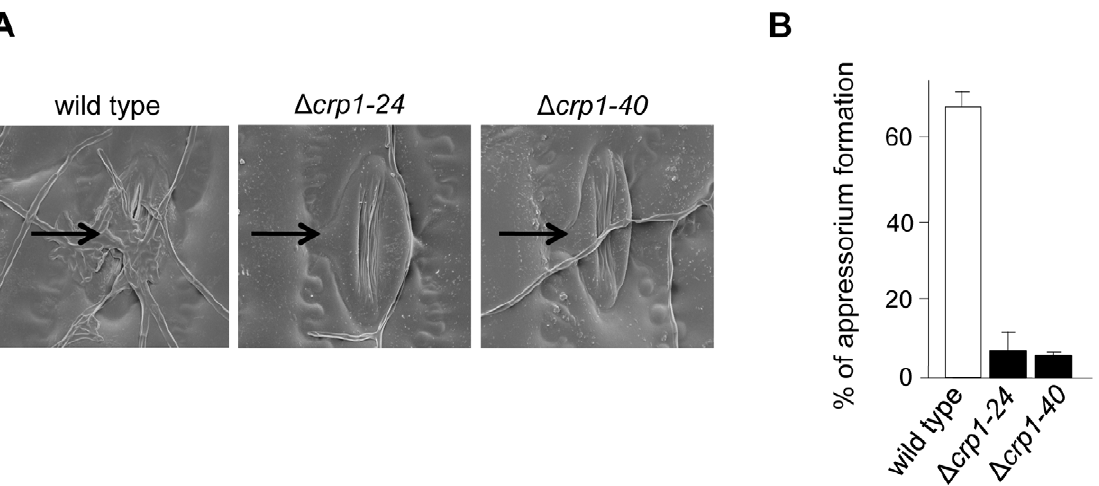
Figure 5. CRP1 regulates appressorium formation and stomatal tropism in C.zeae-maydis . A, leaves inoculated with wild type, the D crp1- 24 mutant, and D crp1-40 mutant were observed with electron microscopy. Stomata are indicated with black arrows. B, ratio of appressoria formed per stomate encountered for the wild type and D crp1 mutants. Ratio was calculated by counting how many appressoria were formed by 100 arbitrarily selected hypha that had physically encountered a stomate.